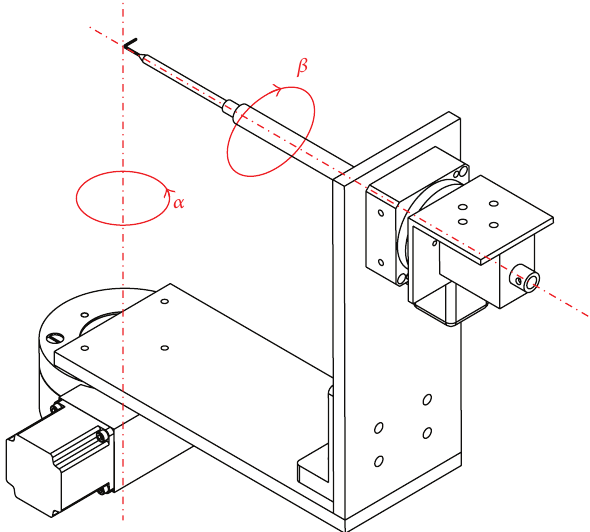
Figure 3: Calibrator design with pitch ( 𝛼 ) and yaw ( 𝛽 )